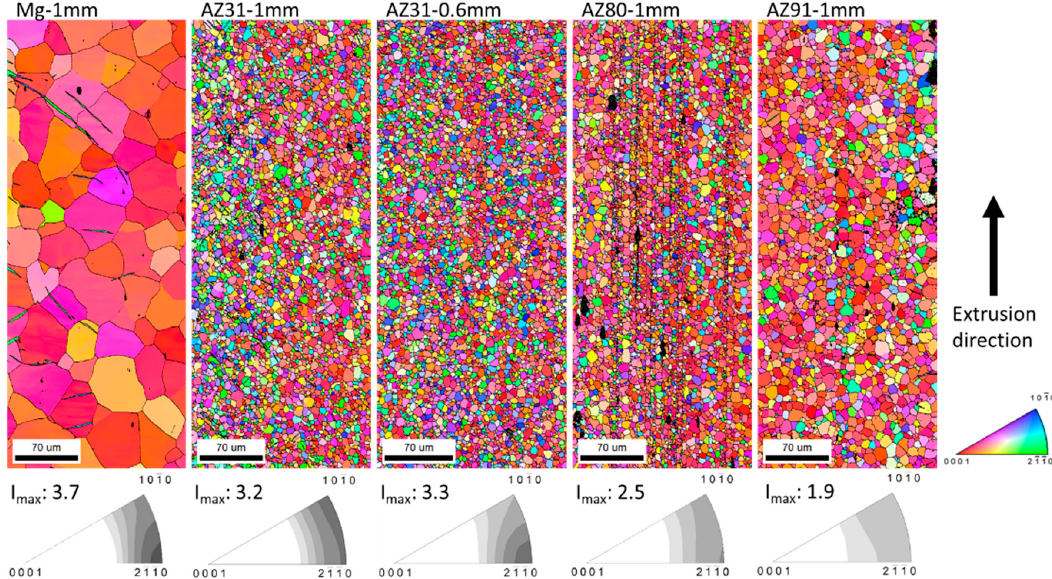
Figure 2. Orientation maps from electron backscatter diffraction (EBSD) measurements on langitudinal section of the extruded wires (extrusion direction (ED) vertical) and the corresponding inverse pole figures in the ED (Level: 1,2, … 5 multiple random degree, m.r.d.).